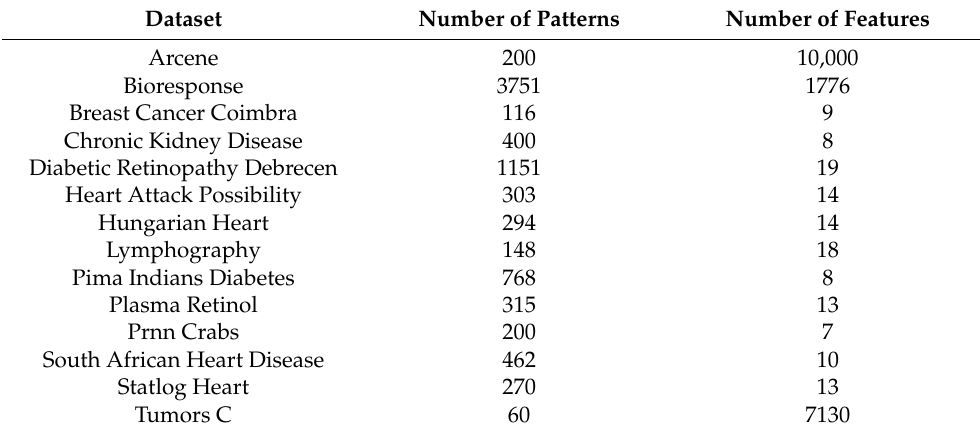
Table 3. Description of the datasets in alphabetical